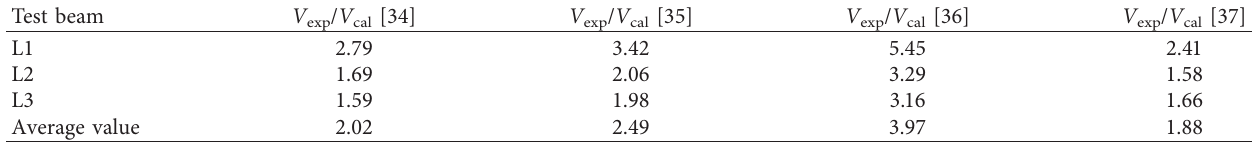
Table 5: Comparison between the test values and code calculated values.